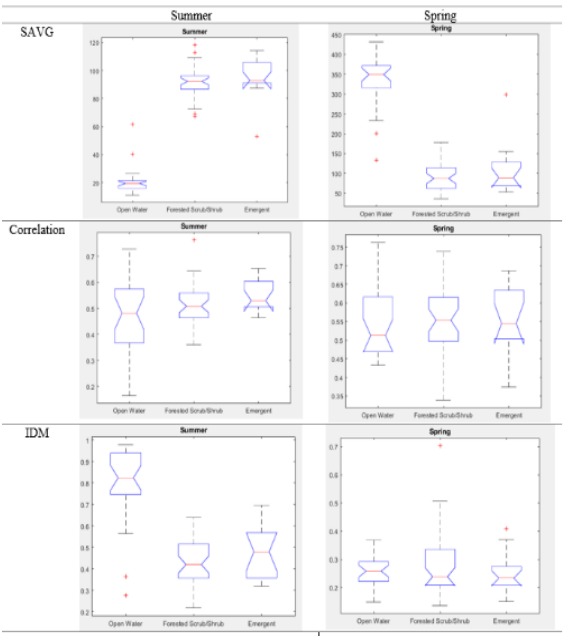
Figure 6 . The box and whisker plots of important GLCM features for different wetland classes in summer and